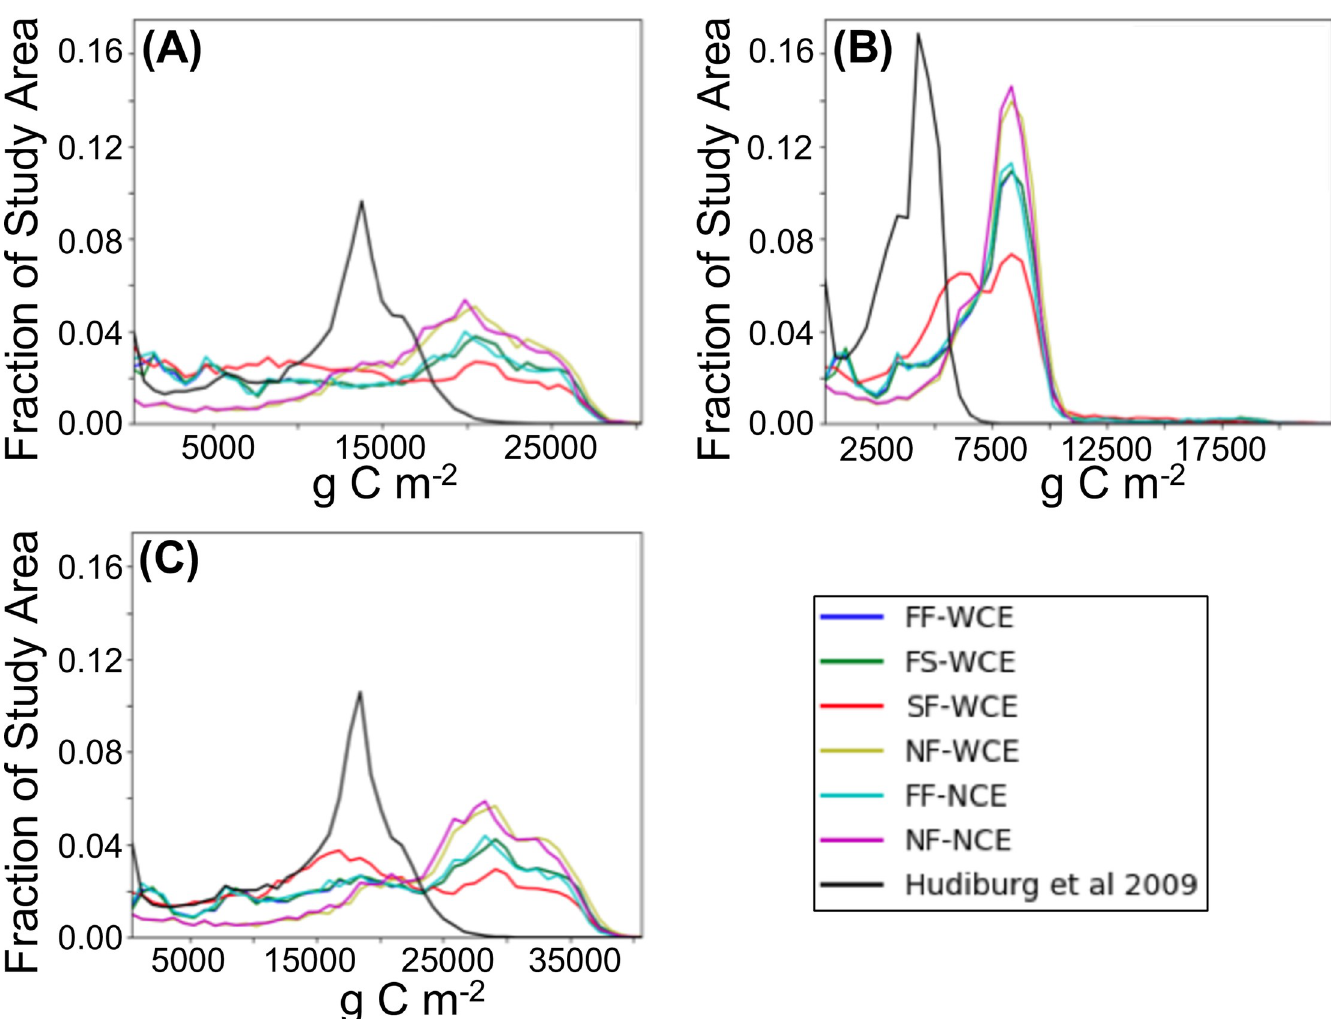
Fig 5. Simulated carbon density distributions by the MC2 vegetation model for natural areas as a fraction of the entire study area. (A) AGB (above ground live woody biomass), (B) AGD (above ground dead woody carbon), and (C) AGT (above ground total woody carbon).